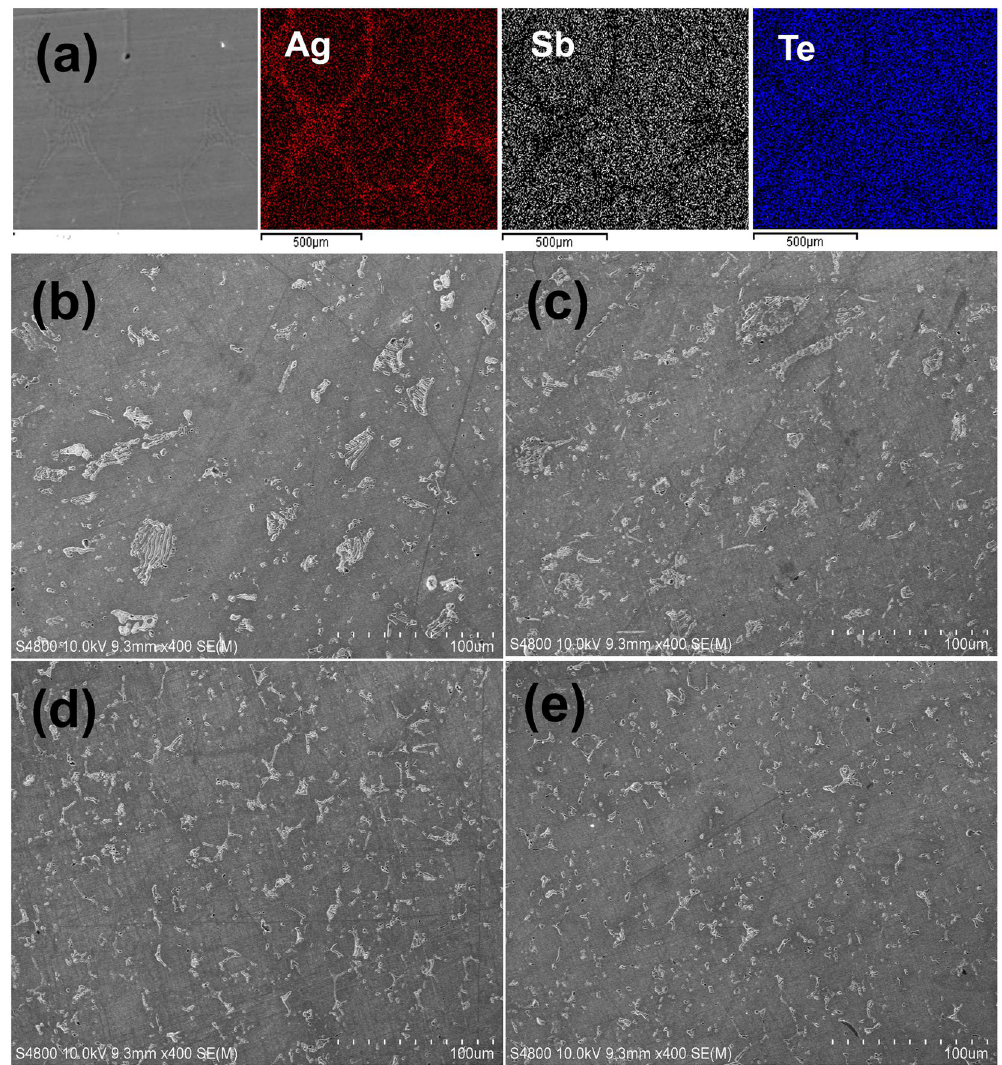
Figure 2. ( a ) SEM images and the elemental distribution of AgSbTe 2 ingots quenched after melting; the region of grain boundaries was identified as Ag 2 Te precipitates, ( b – e ) SEM images of the hot-pressed samples; the light and dark regions are Ag 2 Te precipitates and AgSbTe 2 matrix, respectively; the precipitates crushed from melted ingots remained as isolated precipitates in the sintered samples, ( b ) AgSbTe 2 , ( c ) x = 0.002, ( d ) x = 0.003, and ( e ) x = 0.004 samples in AgSb 1 − x Ce x Te 2